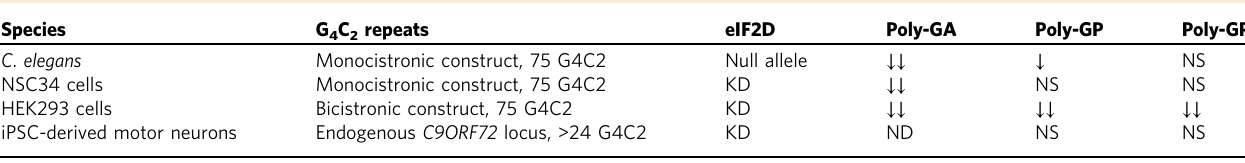
Fig. 6 Knockdown of eIF2D suppresses DPR expression in NSC-34 and HEK293 cells. Monocistronic or bicistronic constructs were cotransfected along with either control or anti-eIF2D shRNA and cultured for 48 h. a Schematic diagram showing C9-HA construct. AG promoter: CMV enhanced chicken β - actin promoter. HA is in poly-GA frame. FLAG and Myc are in poly-GR and poly-GP frames, respectively, but are not schematically depicted. BGH bovine growth hormone. b A representative western blot of NSC-34 lysates to detect poly-GA, eIF2D, and β -actin. c , d Quanti fi cation of eIF2D ( c ) and poly-GA ( d ) expression from the western blots. e – f Quanti fi cation of poly-GP ( e ) and poly-GR ( f ) by ELISA in NSC-34 cells. The experiments were repeated four times. mean ± s.e.m. Turkey ’ s multiple comparisons test was used to calculate P -values. One-way ANOVA with Tukey ’ s multiple comparisons test was performed. g Schematic diagram showing the bicistronic constructs. CMV cytomegalovirus promoter; fLuc fi re fl y luciferase; nLuc nanoluciferase; BGH bovine growth hormone. h The cell lysates were processed for western blotting and immunostained with poly-GA, fLuc, eIF2D, and α -tubulin antibodies. i , j , n Quanti fi cation of eIF2D ( i ), poly-GA( j ), and fLuc ( n ) on western blots. The experiments were repeated three times. mean ± s.e.m. Two-tailed unpaired t -test was performed. k The levels of luciferase activity were assessed by dual-luciferase assays. The experiments were repeated three times. mean ± s.e.m. l , m Poly-GP and poly-GR detected with ELISA in HEK293 cells transfected with a Δ C9 or C9 bicistronic construct. The experiments were repeated three times. mean ± s.e.m. Two-tailed unpaired t -test was performed.